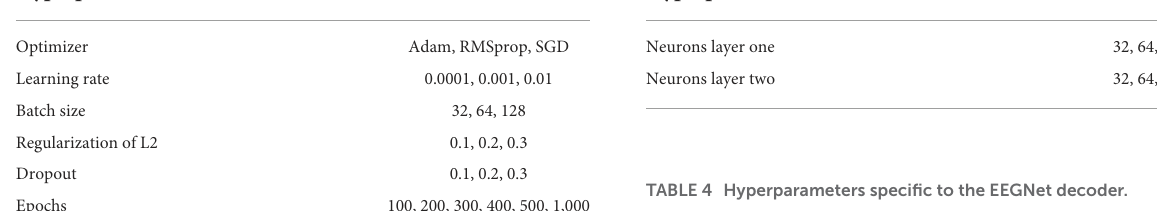
TABLE 4 Hyperparameters specific to the EEGNet